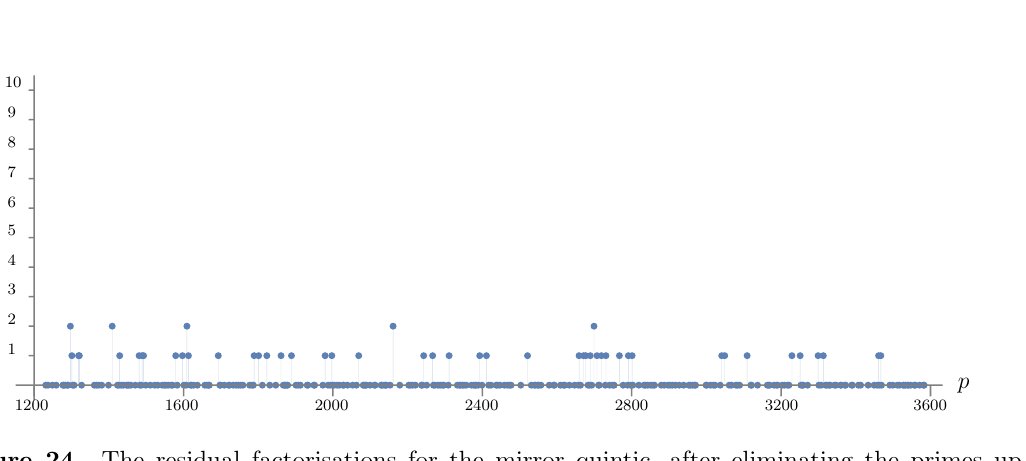
Figure 24 . The residual factorisations for the mirror quintic, after eliminating the primes up to p 200